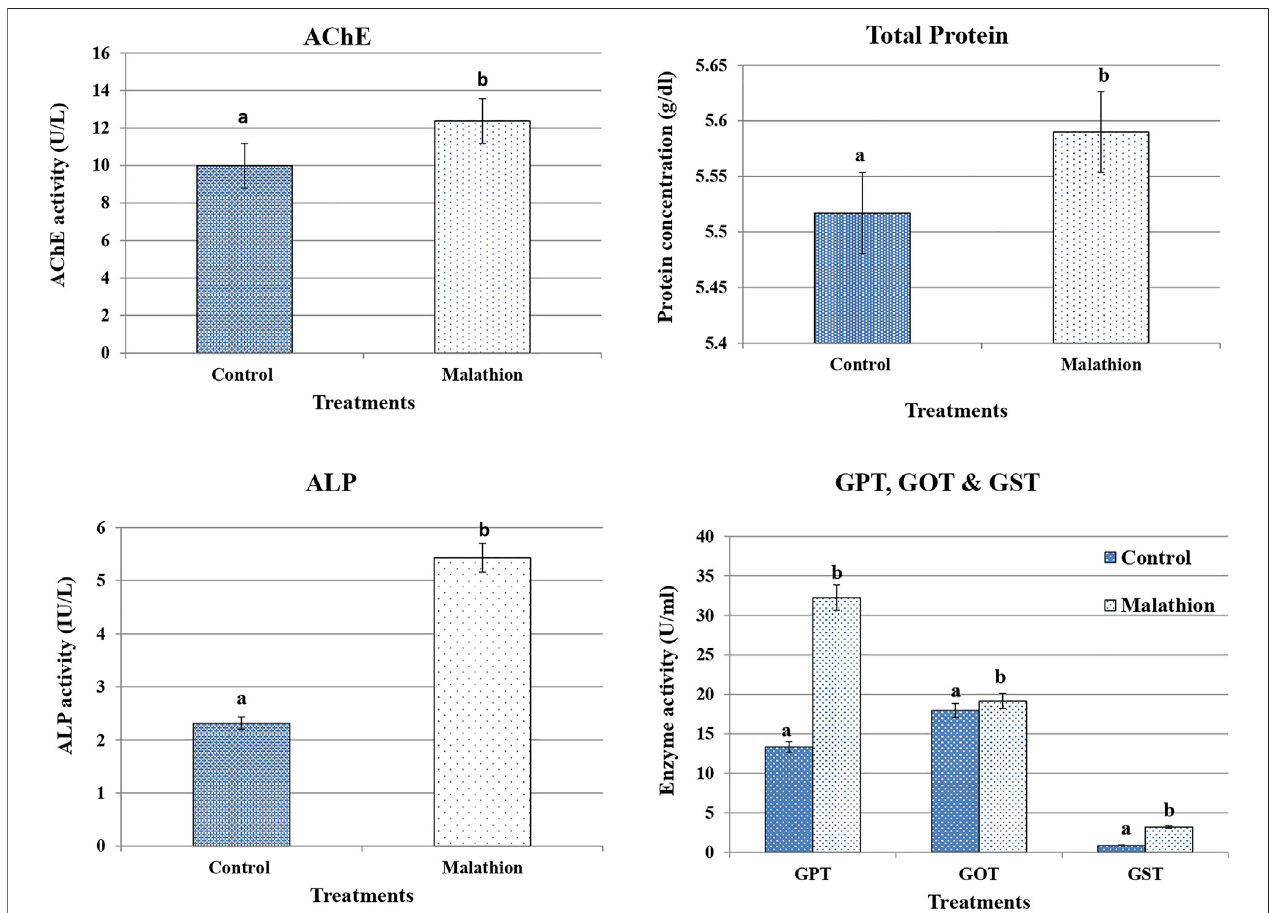
FIGURE 1 | Effectof malathion on AChE, total protein, ALP GPT, GOT, and GST in malerats after 24 h of treatment compared to control. Bars represent means ± SD. * p < 0.05 versus control. Different letters (A,B) indicate the signi fi cant differences between means according to Duncan ’ s multiple range test.